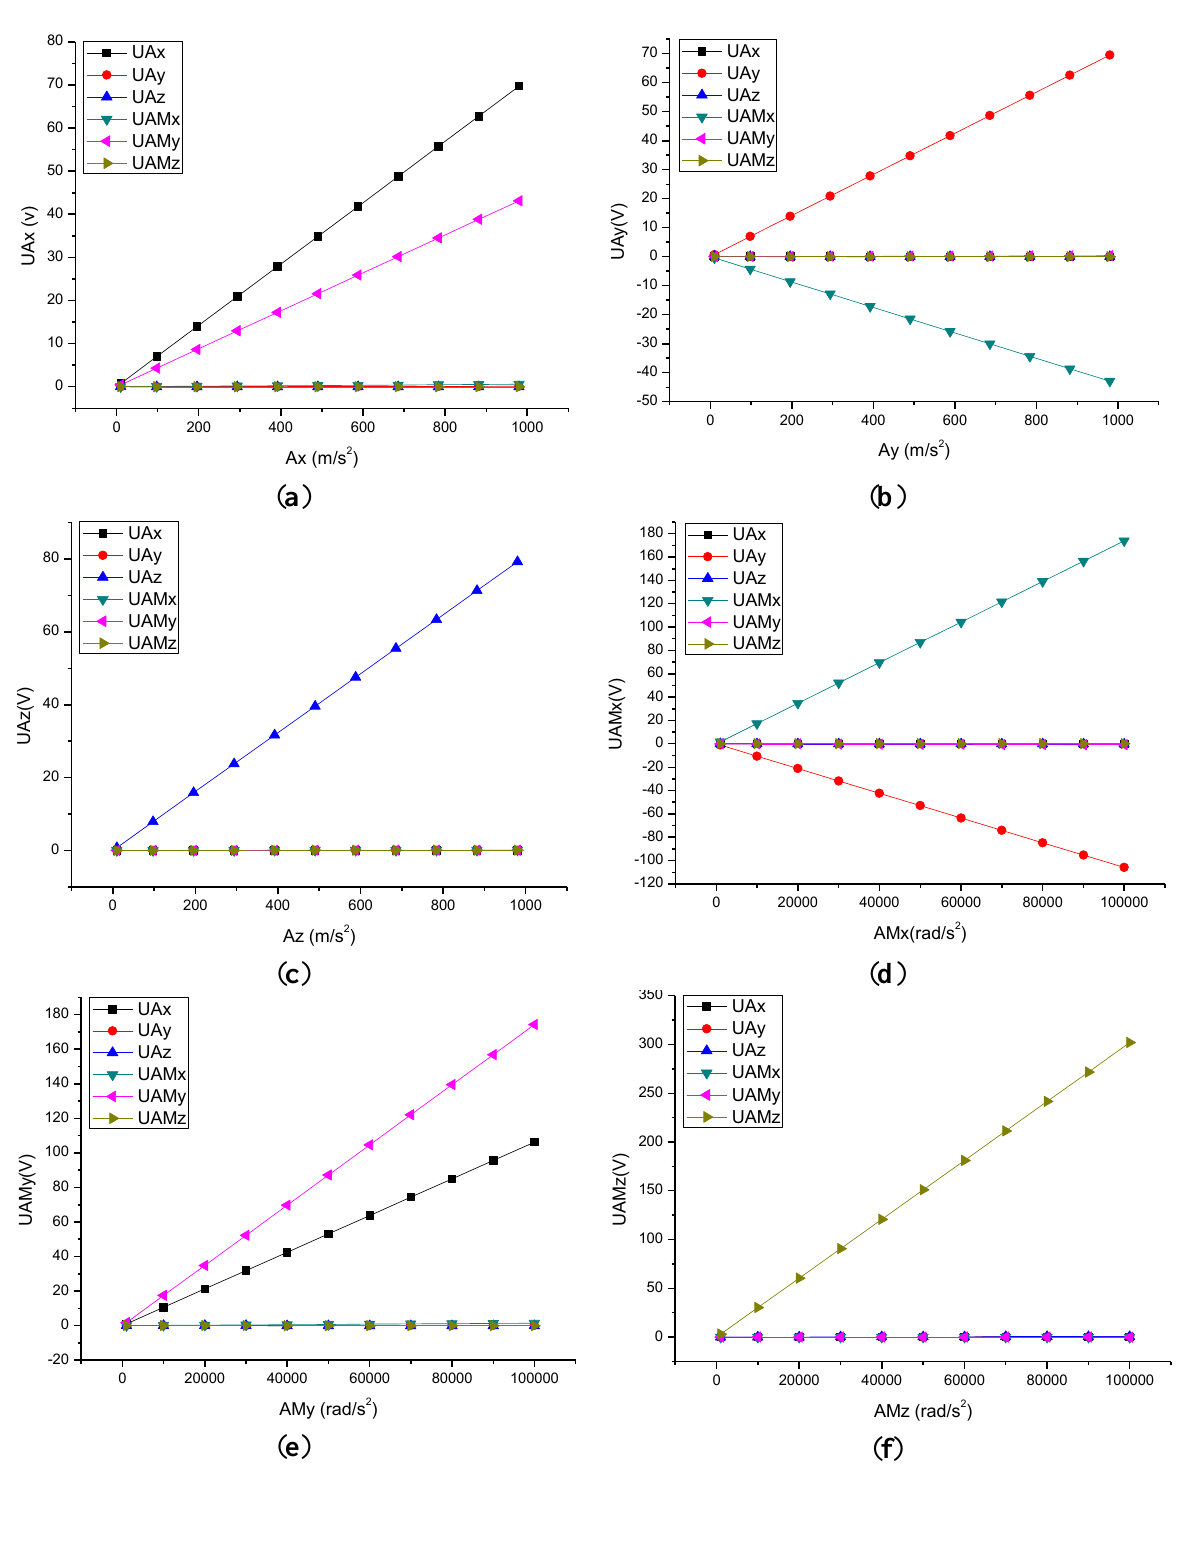
Figure 3. Piezoelectric six-DOF sensor’s input acceleration and output voltage curve. ( a ) X-axis linear acceleration; ( b ) Y-axis linear acceleration; ( c ) Z-axis linear acceleration; ( d ) X-axis angular acceleration; ( e ) Y-axis angular acceleration; ( f ) Z-axis angular